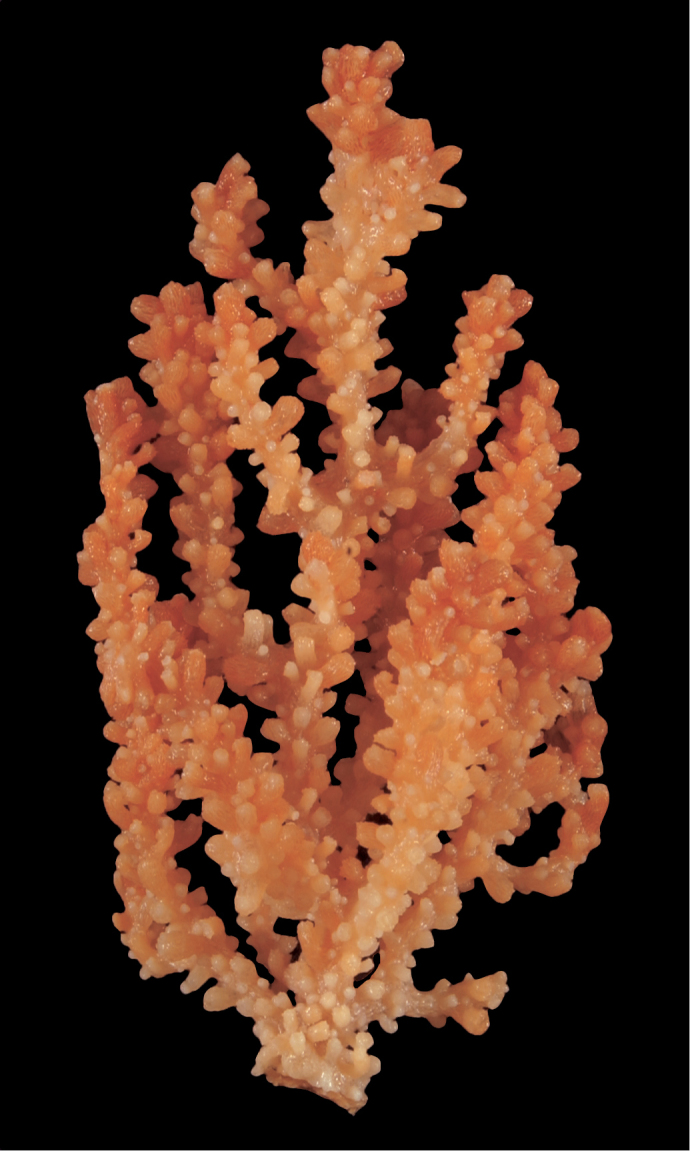
Muriceafruticosa, SBMNH 265945. Colony measures ~7.5 cm × 4.0 cm. Visible in image is the pale cream/yellow base/lower trunk; trunk intensifies and darkens to brownish orange towards branch tips. Notice swollen appearance of branch tips.